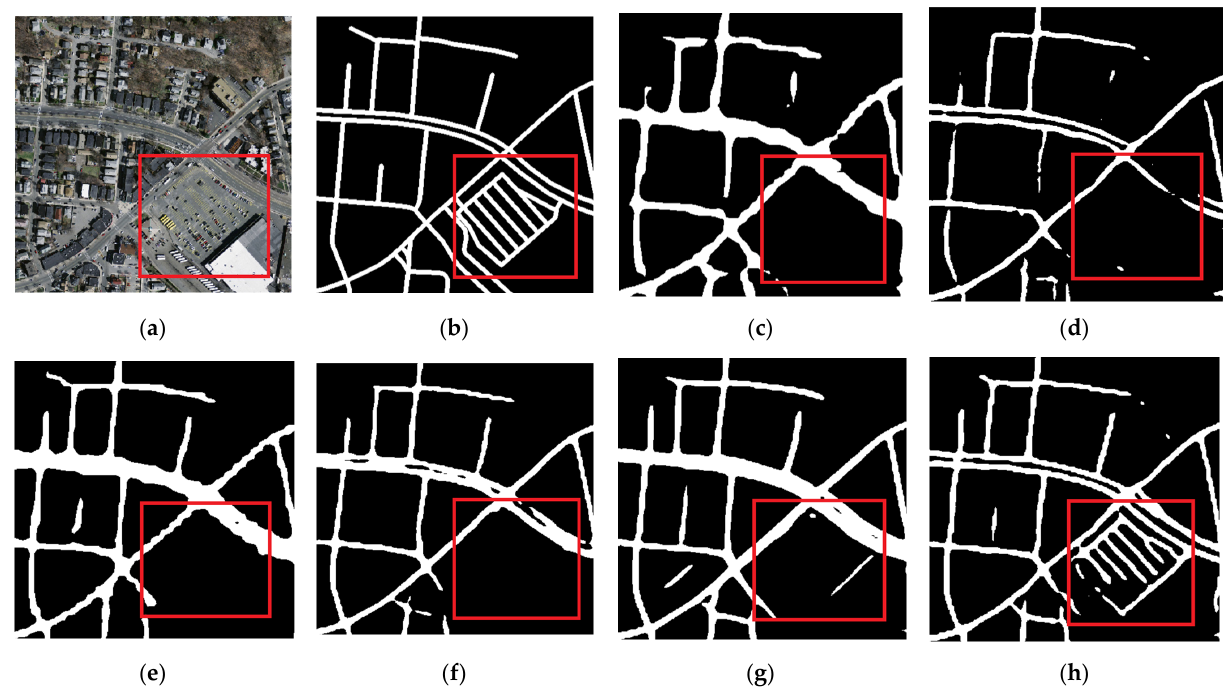
Figure 8. Results of road extraction (the road is similar to the background). ( a ) Image; ( b ) Label; ( c ) DeepLabv3+; ( d ) U-Net; ( e ) HRNetV2; ( f ) D-LinkNet; ( g ) RefineNet; and ( h ) MSPFE-Net.( Red squares represent key areas.)